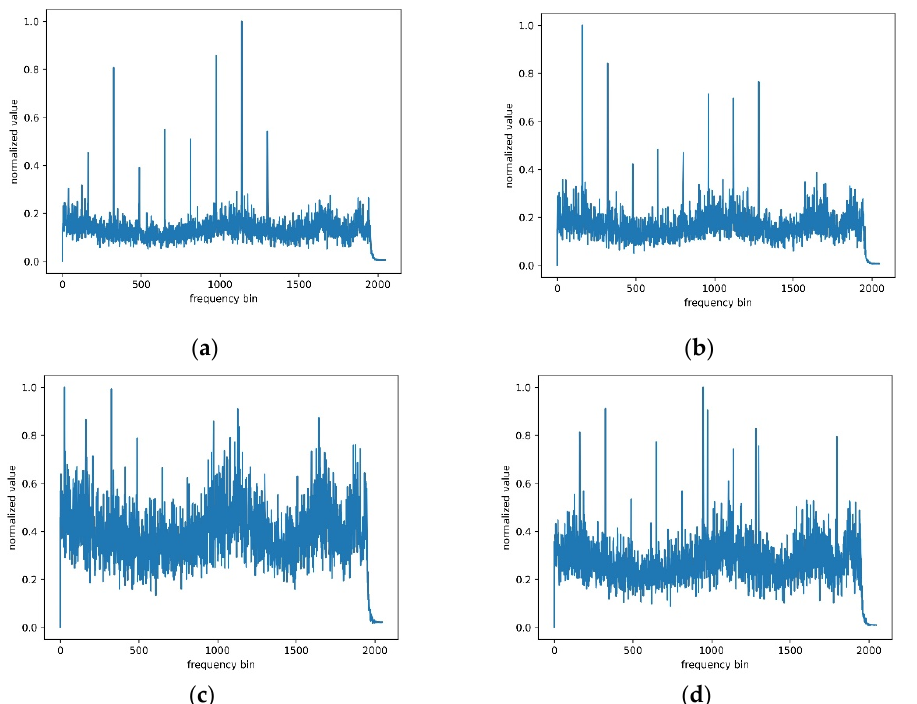
Figure 2. The DEMON spectrum of different parameters. ( a ) DEMON spectrums of a reference sample; ( b ) DEMON spectrums of a sample with Doppler shifts; ( c ) DEMON spectrums of a sample with low SNR; ( d ) DEMON spectrums of a sample with interferences.